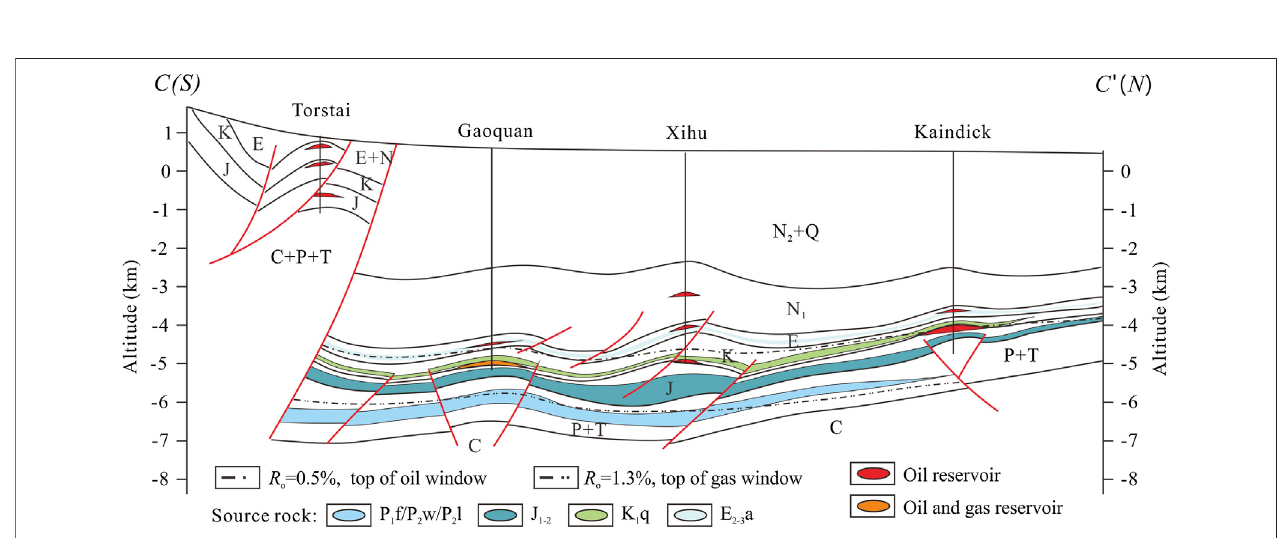
FIGURE 9 | Sketch diagram of structure, source rock burial evolution and hydrocarbon migration and accumulation section in the west of southern margin.